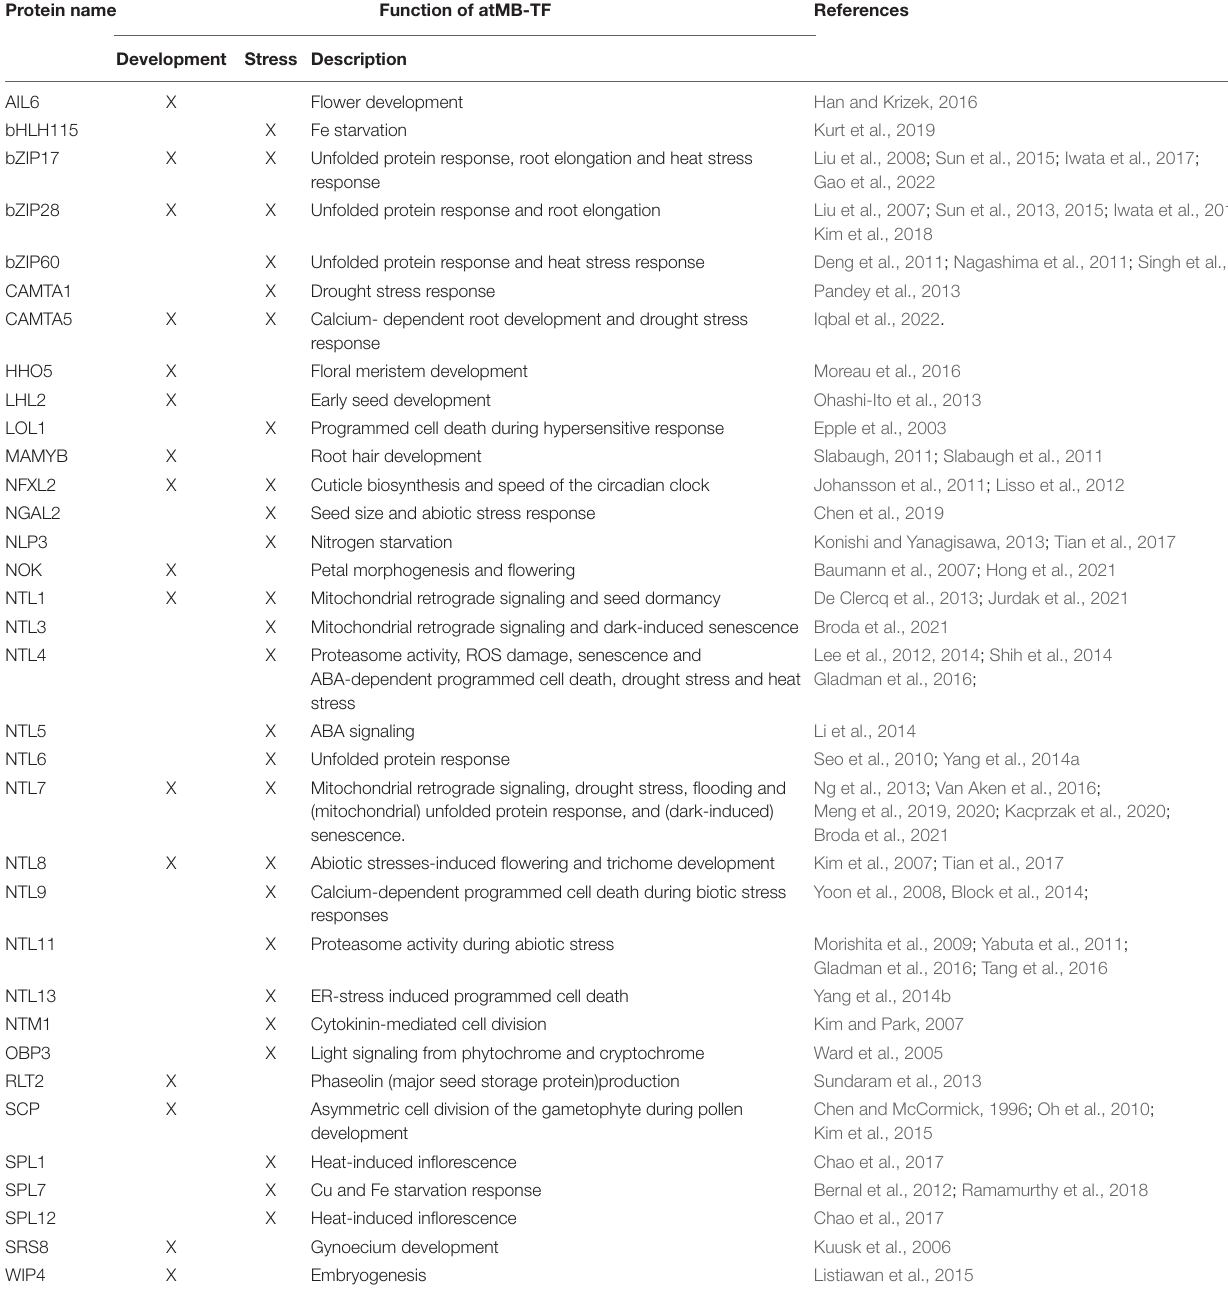
TABLE 2 | Overview of known functions of atMB-TFs in plant development and stress responses. Protein